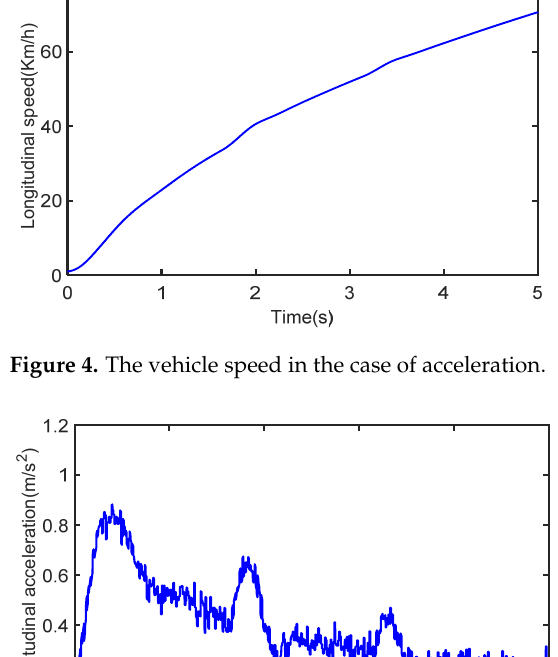
Figure 6. The tire forces in the case of acceleration.